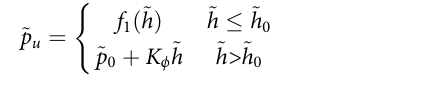
as well as for reasons to be understood below, we scaled the mean